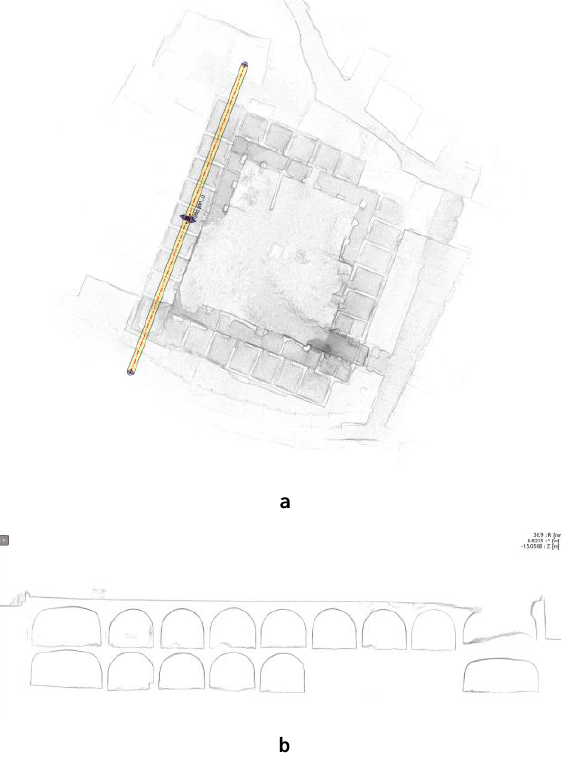
Figure 6. Projection of the 1 st floor based on the pointcloud from the SLAM laser scanning (a); cross-section creating